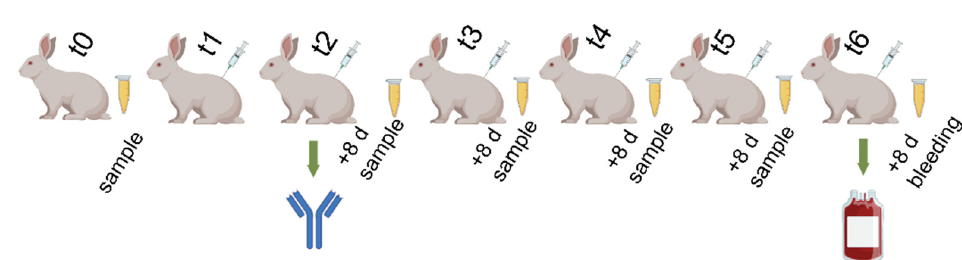
Table 1. Scorpions venoms LD 50 . Median lethal doses (LD 50 ) of each scorpion venom batch, deter-